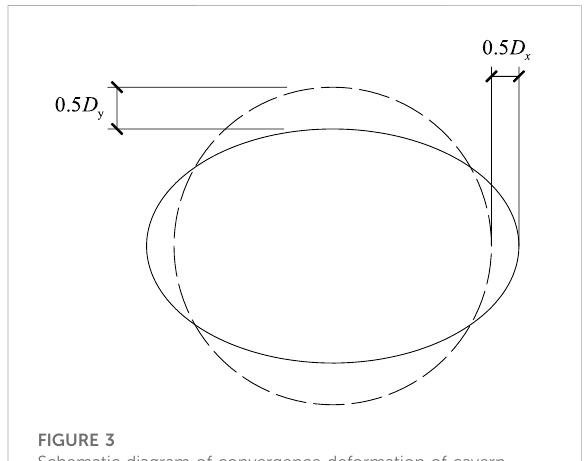
FIGURE 3 Schematic diagram of convergence deformation of cavern.